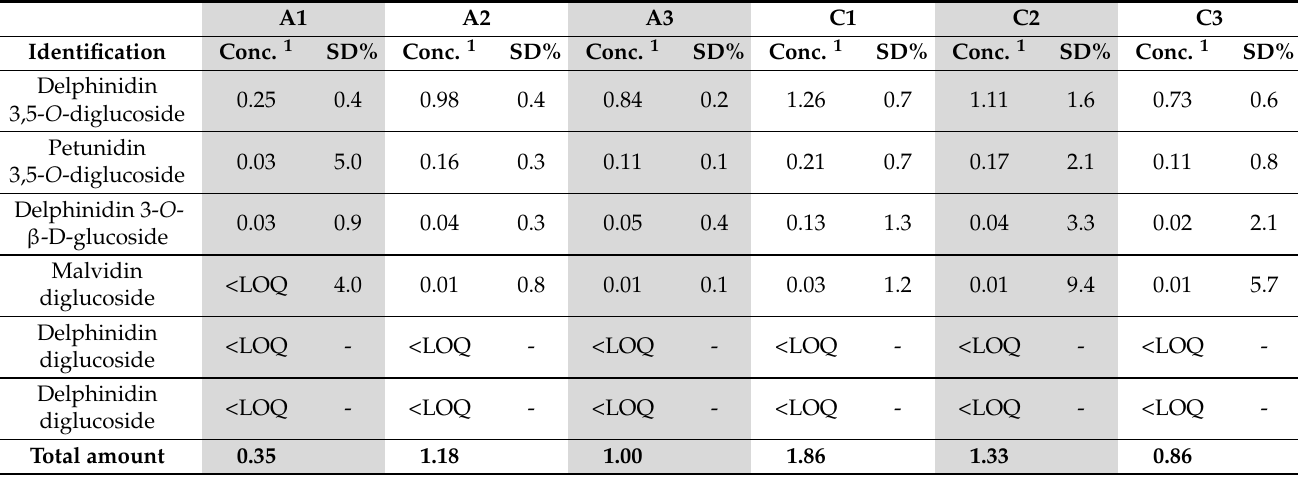
Table 4. Quantification of anthocyanins by using UPLC-DAD-ESI-MS expressed as mg of delphinidin 3- O -glucoside equivalent per gram of DW of raw material. Each sample was extracted in triplicate and individually analyzed. The standard deviation was calculated on three